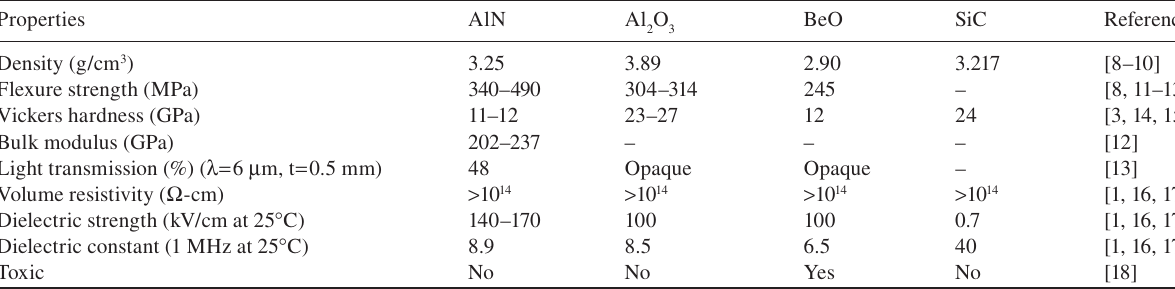
Table 1 Electrical properties of AlN and some ceramics used as substrates.